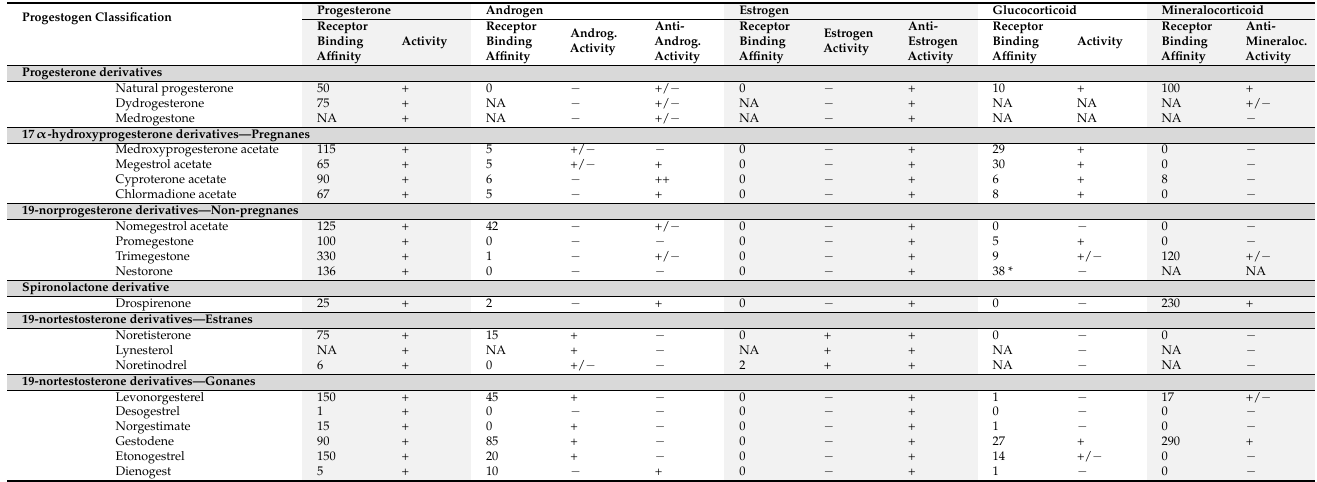
Table 4. Patterns of hormonal activities and relative binding affinities to steroid receptors of the main progestogens. Here, 100% binding affinities are related to following steroids: Progesterone receptor (promegestone, 100%), androgen receptor (metribolone R1881, 100%), estrogen receptor (17 β -estradiol, 100%), glucocorticoid receptor (dexamethasone, 100%), and mineralocorticoid receptor (aldosterone, 100%). The data are predominately based on animal studies and compiled from the literature [145–152]. The clinical effects of individual substances are dependent on their biological concentrations. The values of relative binding affinities may be inconsistent due to various laboratory protocols, conditions and biological materials used. The anti-estrogen activity of all progestogens is not caused by binding to estrogen receptors but rather by repression of the transcriptional activity of estrogen receptors by PRs. Androgen Estrogen Glucocorticoid Mineralocorticoid Receptor Anti- Receptor Anti- Receptor Receptor Anti- Receptor Androg. Estrogen Binding Androg. Binding Estrogen Binding Activity Binding Mineraloc. Activity Binding Activity Activity Affinity Activity Affinity Activity Affinity Affinity Activity Affinity